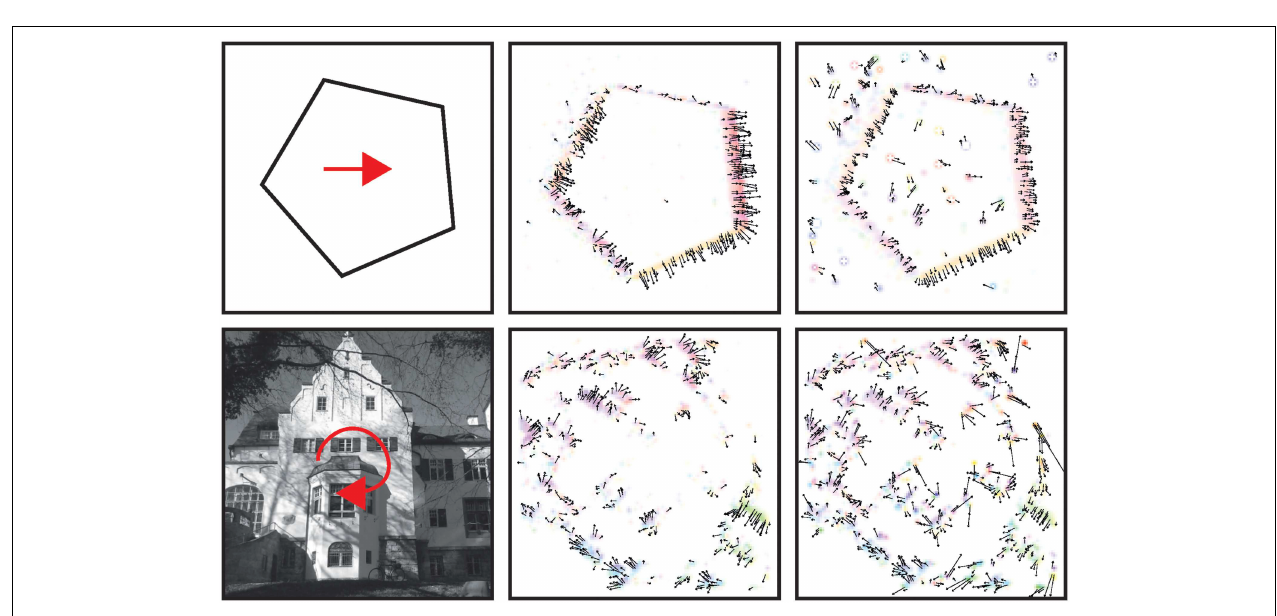
FIGURE 8 | Responses to input stimuli with translatory and rotational motion. From left to right: Test stimulus and vector field of initial motion estimation using the filter mechanism in Equation (25) and after normalization (red arrows are not part of stimulus; only two representative stimuli are shown due to space constraints). First row: Translatory motion stimulus illustrates that a majority of the responses point into the normal flow-direction, i.e., orthogonal to the stimulus boundaries. Last row: A